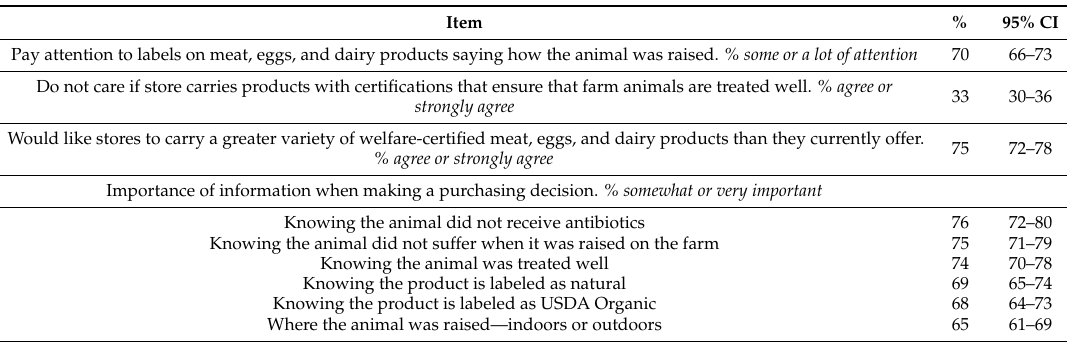
Table 3. Consumers’ considerations when making purchasing decisions. Item % 95%